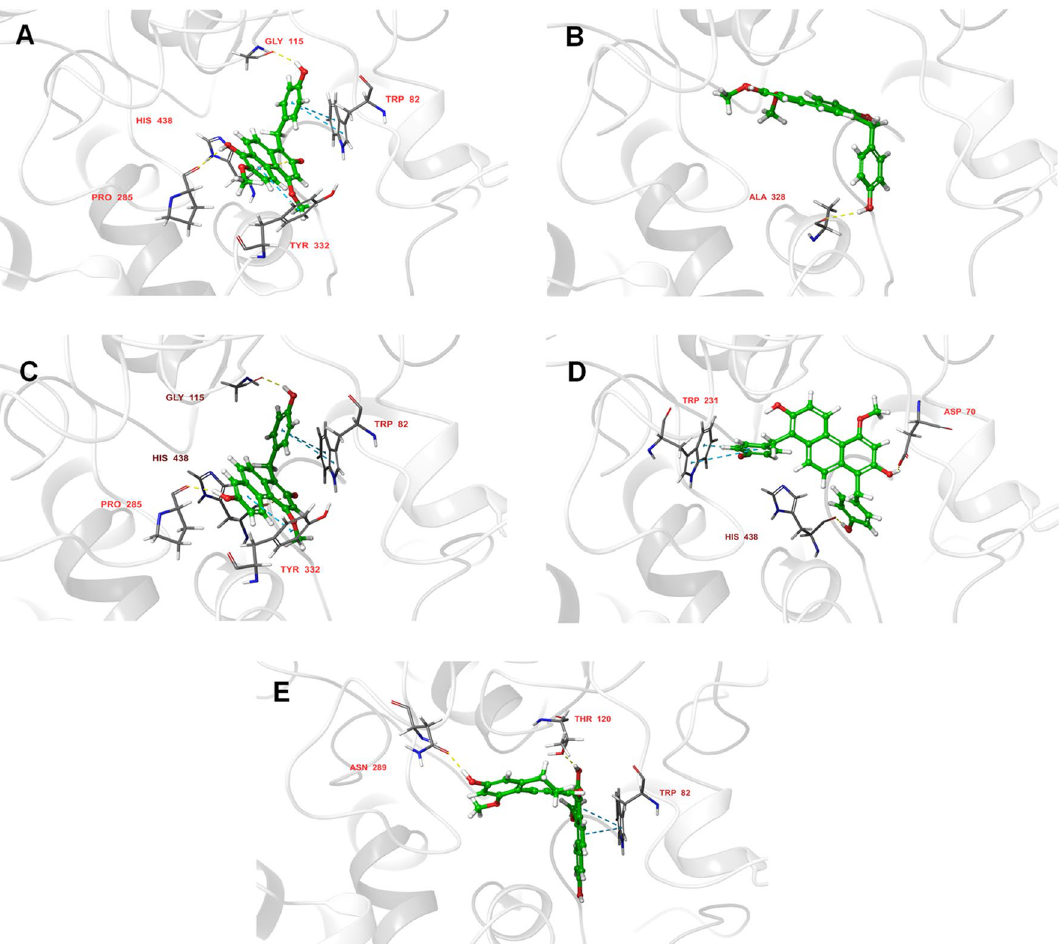
Figure 3. Interacting residues of BChE with five potent inhibitors ( A for 6 , B for 8 , C for 10 , D for 12 , E for 14 ) were shown in sticks colored by atom type, the carbon in green, hydrogen in white, nitrogen in blue, and oxygen in red. Interactions included non-covalent bonds and π interaction, the hydrogen bonds in yellow, π-π stacking in blue.